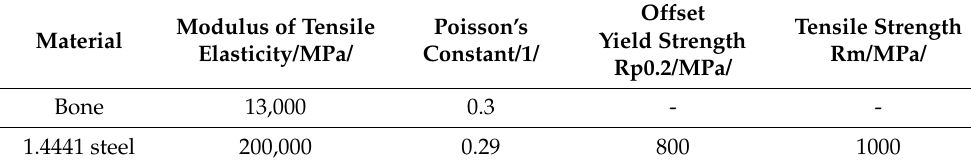
Table 1. Mechanical properties of materials used.